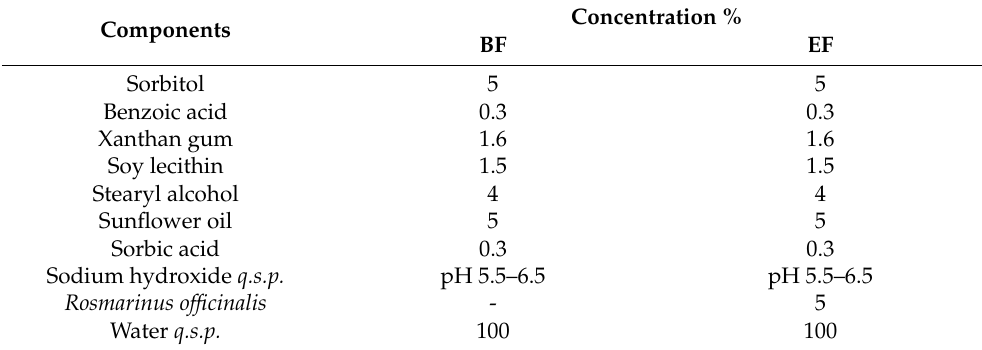
Table 6. Components of blank (BF) and Rosmarinus officinalis extract (EF) formulations. Components